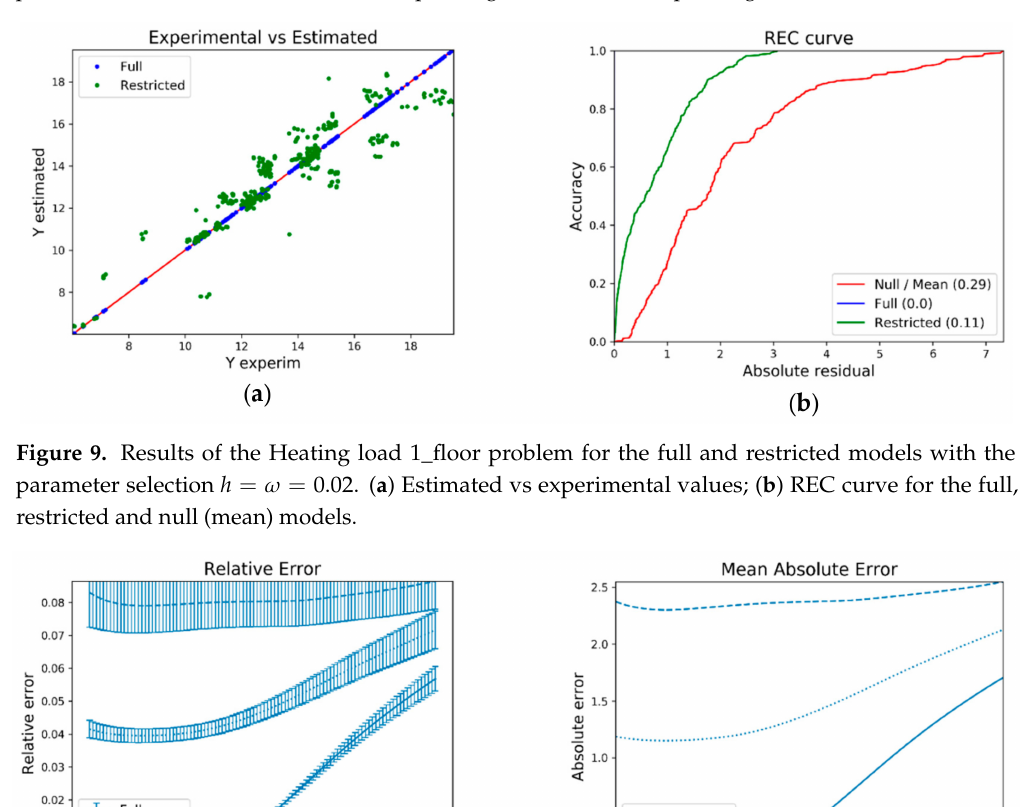
Figure 8. Results of the heating load 1_floor problem for the full, restricted and mixed models with the parameter selection h = ω . ( a ) MAPE depending on h ; ( b ) MAE depending h .